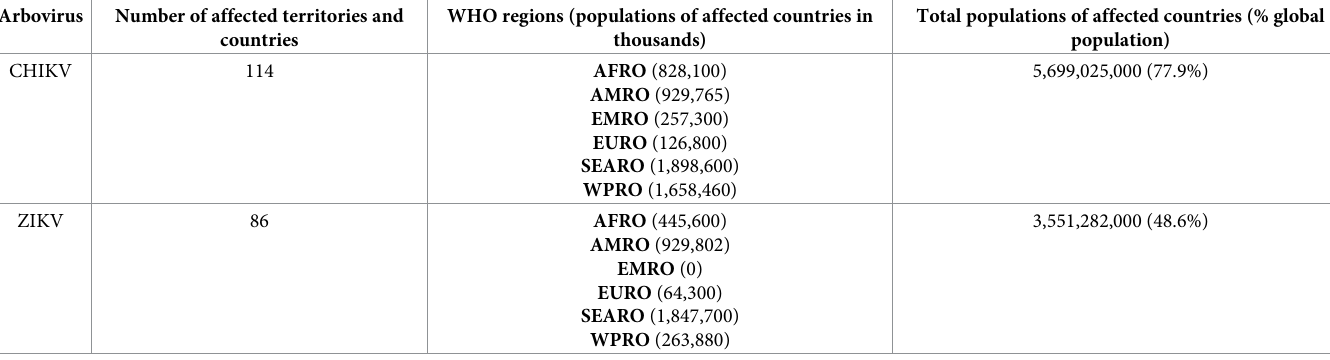
AFRO, African region; AMRO, Americas region; CHIKV, chikungunya virus; EMRO, Eastern Mediterranean region; EURO, European region; SEARO, Southeast Asia region; WPRO, Western Pacific region; ZIKV, Zika virus. The populations listed were quantified according to the 2015 estimates given in the United States Census Bureau’s International Database (https://www.census.gov/data-